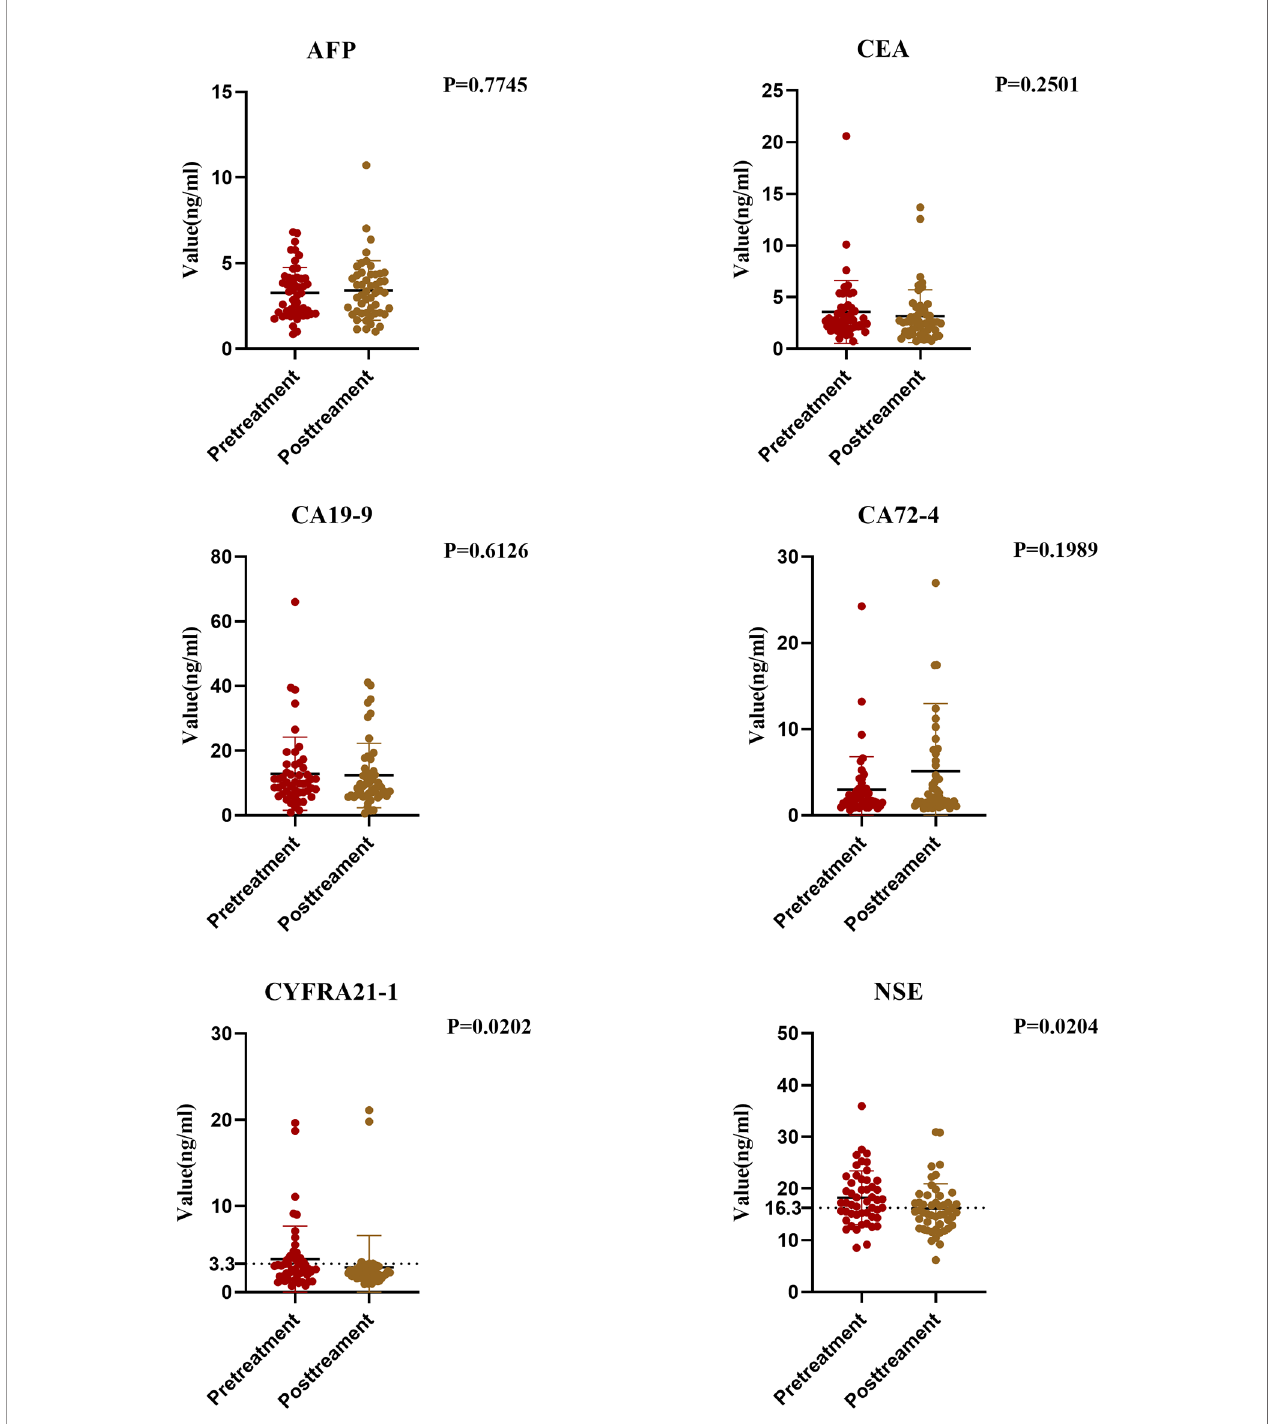
FIGURE 4 | Comparison of Tumor Markers between Pretreatment and Posttreatment